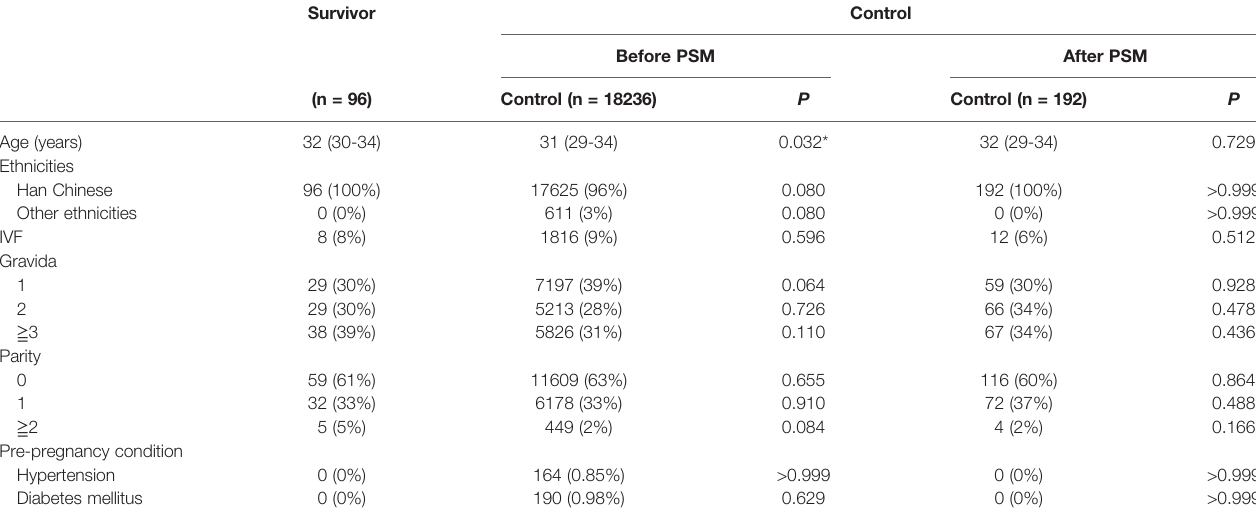
TABLE 1 | Characteristics of the factors in propensity score